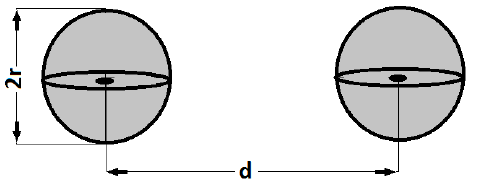
Figure A2. Two metal particles forming an electric capacitor [55,56].